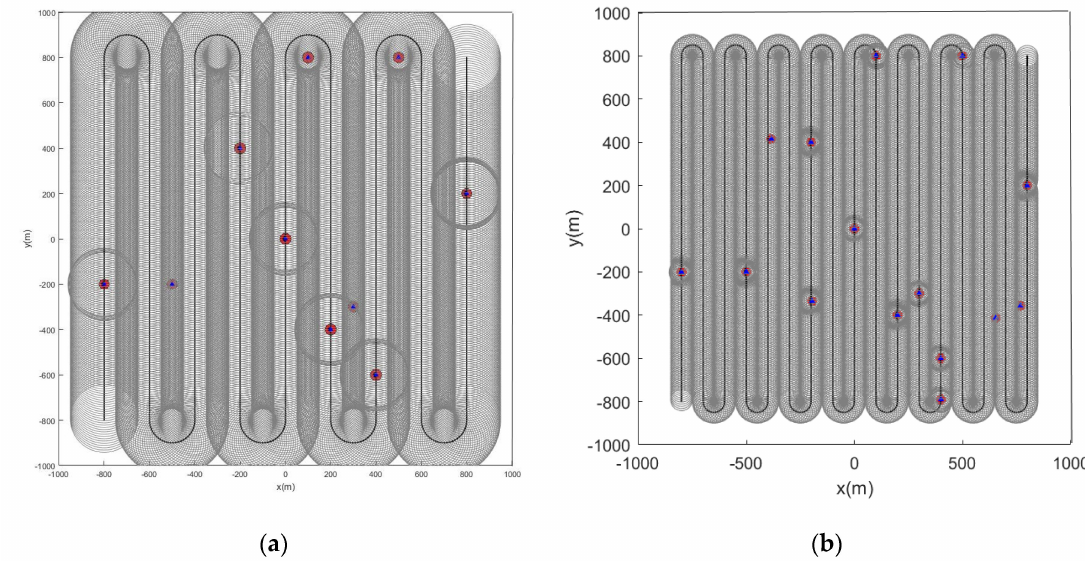
Figure 7. Estimated position of stationary feature points using the GLMB algorithm (the red and blue marks indicate the true and estimated positions, respectively, of the feature points in the scene): ( a ) the detection radius of the sensor is 150 m, there are 10 feature points in the scene; ( b ) sensor detection radius is 50 m, there are 15 feature points in the